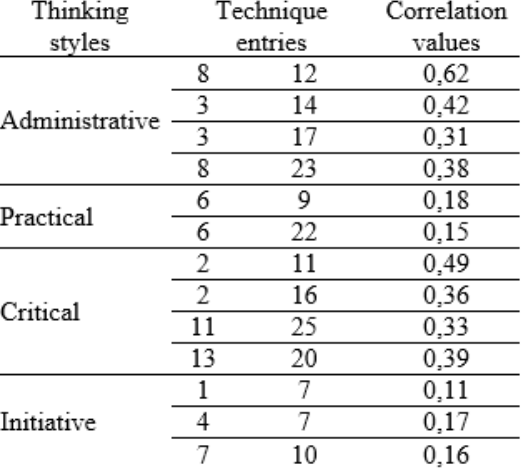
Table 3. Correlation values between